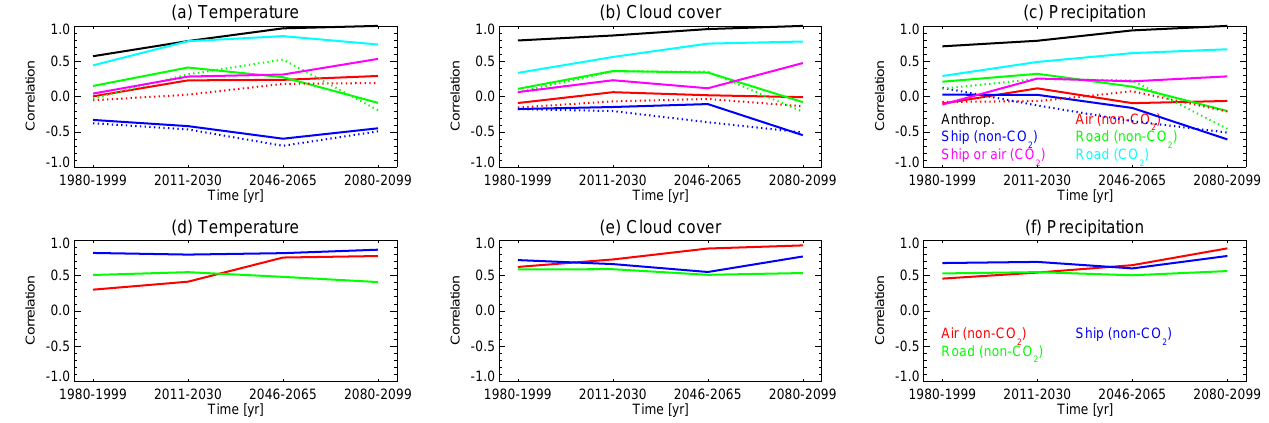
Fig. 12. First row: correlation between the impact on the geographical distributions of annual mean (a) surface air temperature, (b) cloud cover and (c) precipitation from a perturbation in a certain period with the total anthropogenic impact of the period 2080–2099. The dotted lines show the result for the fixed O 3 approach. Second row: correlation between the two different non-CO 2 approaches (fixed O 3 versus dynamical O 3 approach) for (d) surface air temperature, (e) cloud cover and (f) precipitation.